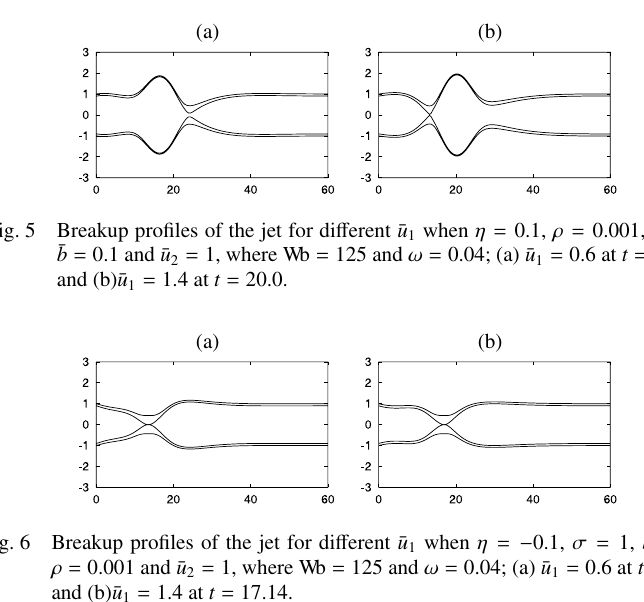
= 0 . 6 at t = 15 . 85 1